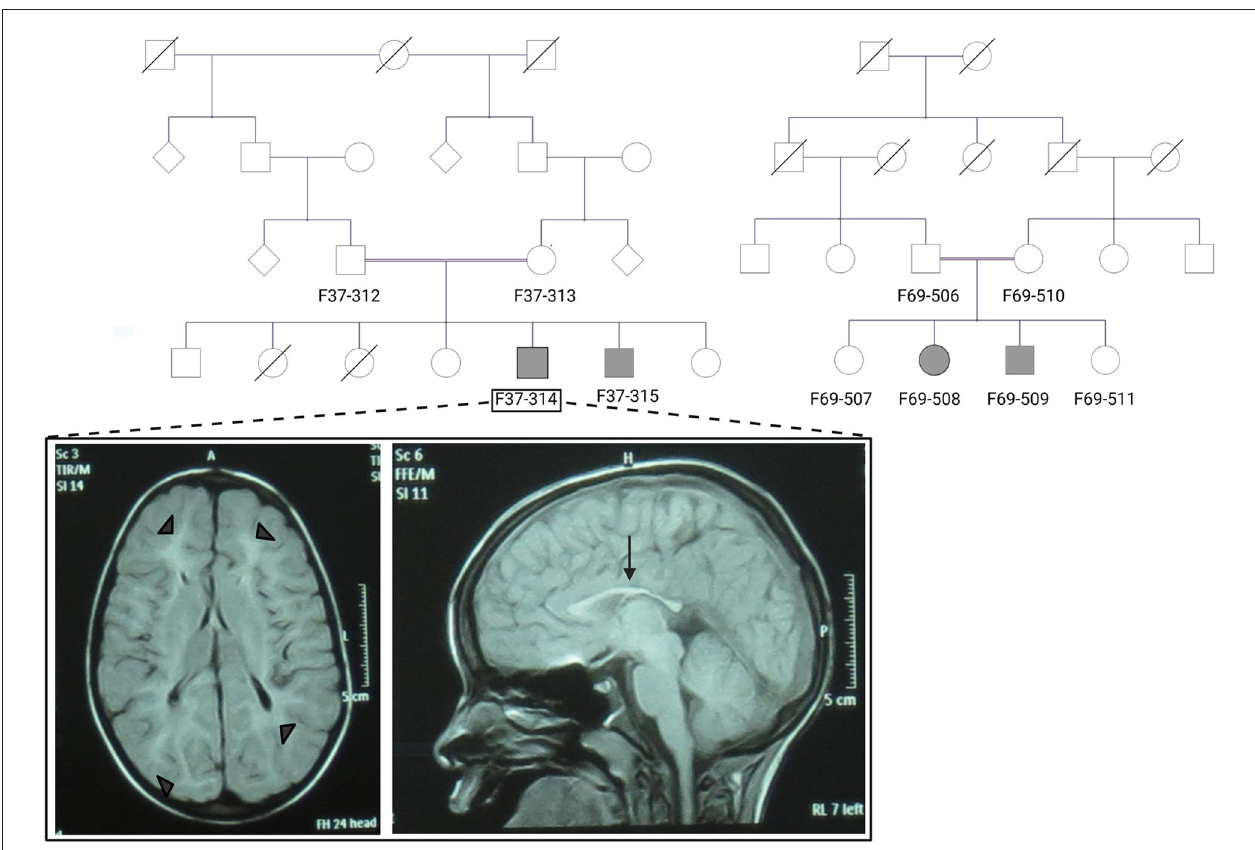
FIGURE 1 | The pedigrees of families F37 and F69 and patient F37-314 brain MRI. The family pedigrees of family F37 (left) and F69 (right) show consanguinity in the two families. Axial T2 TIRM dark fluid brain MRI of patient F37-314 shows periventricular and subcortical white matter hyperintensities (left image: arrow heads), whereas sagittal T1 image shows thin corpus callosum (right image: